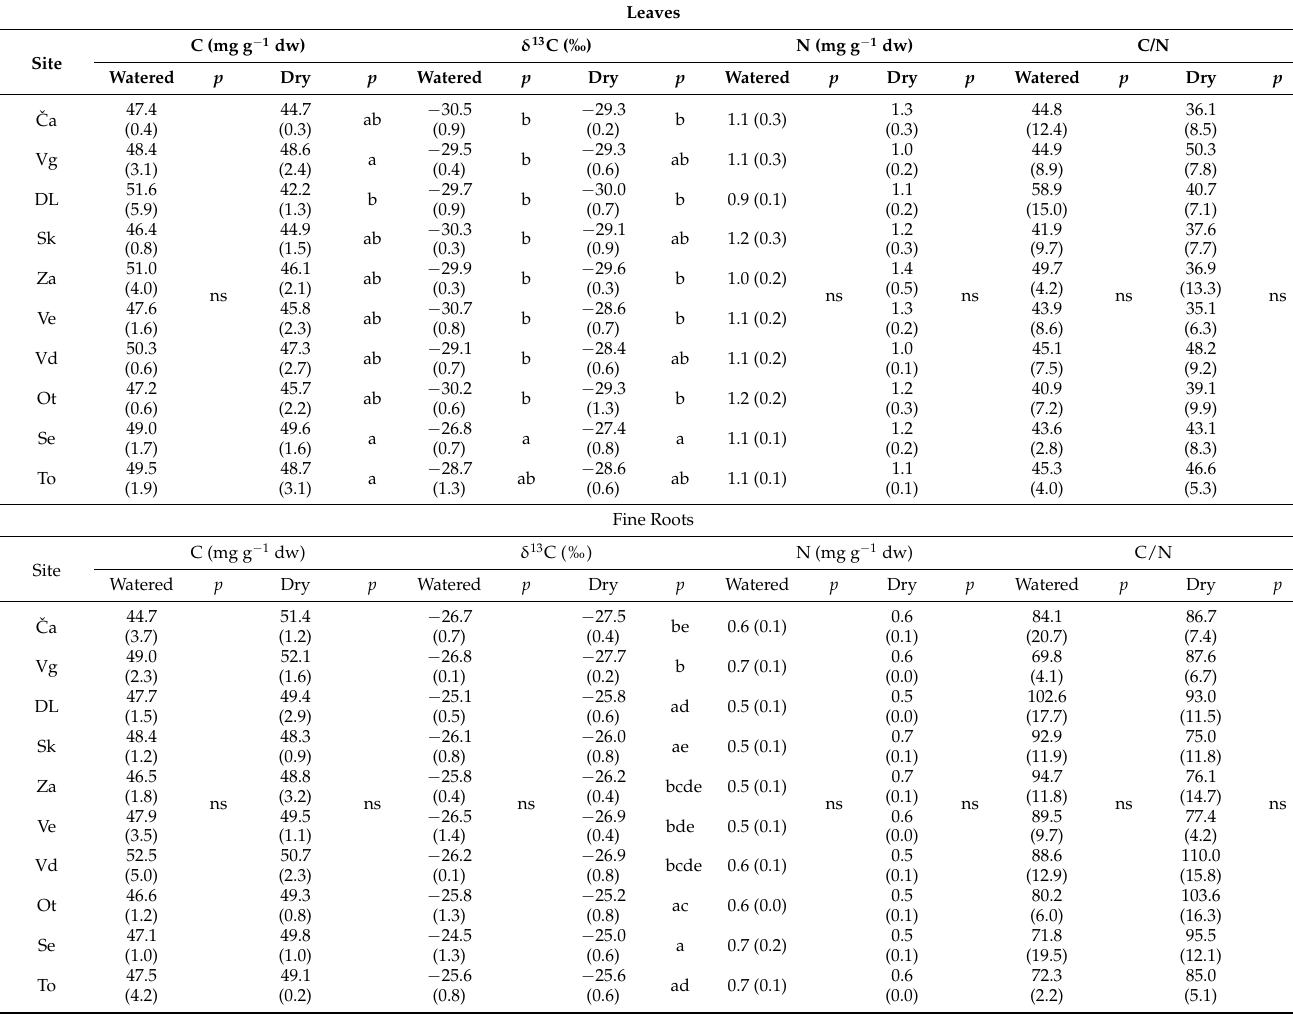
in the soil (sum of Pi min and Pi org ). The bars show means ± S.D.s of four replicates in the well- watered treatment and five replicates in the drought treatment. Black bars = Pi; grey bars + negative whiskers = red Asc; white bars + negative whiskers = DHA; red line + positive whiskers = total Asc (sum of red Asc and DHA); dashed bars + positive whiskers = Asc redox state. Different capital letters indicate statistically significant differences in foliar total Asc between the ecotypes. Minor letters represent statistically significant differences in foliar DHA between the ecotypes. Ns = not significant. Results were derived from one-way ANOVAs at ** p < 0.01. Table 5. C, N, δ 13 C, and C/N ratios in leaves and fine roots. Data shown are mean values ± S.D.s of four replicates for well-watered saplings and five replicates for drought-stressed saplings. p = results of one-way ANOVAs for the well-watered and drought treatments for the different ecotypes. Different minor letters represent statistically significant differences between ecotypes at p < 0.01. Beech ecotypes according to decreasing total Pi.